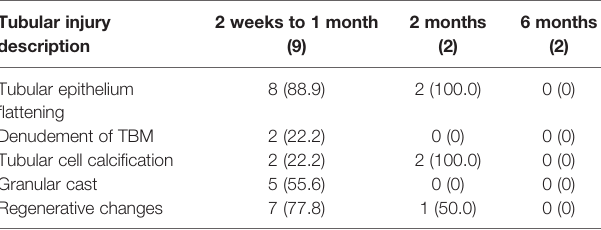
TABLE 7 | Histopathological change of renal tubule in severe tubular injury after kidney transplantation. Tubular injury description